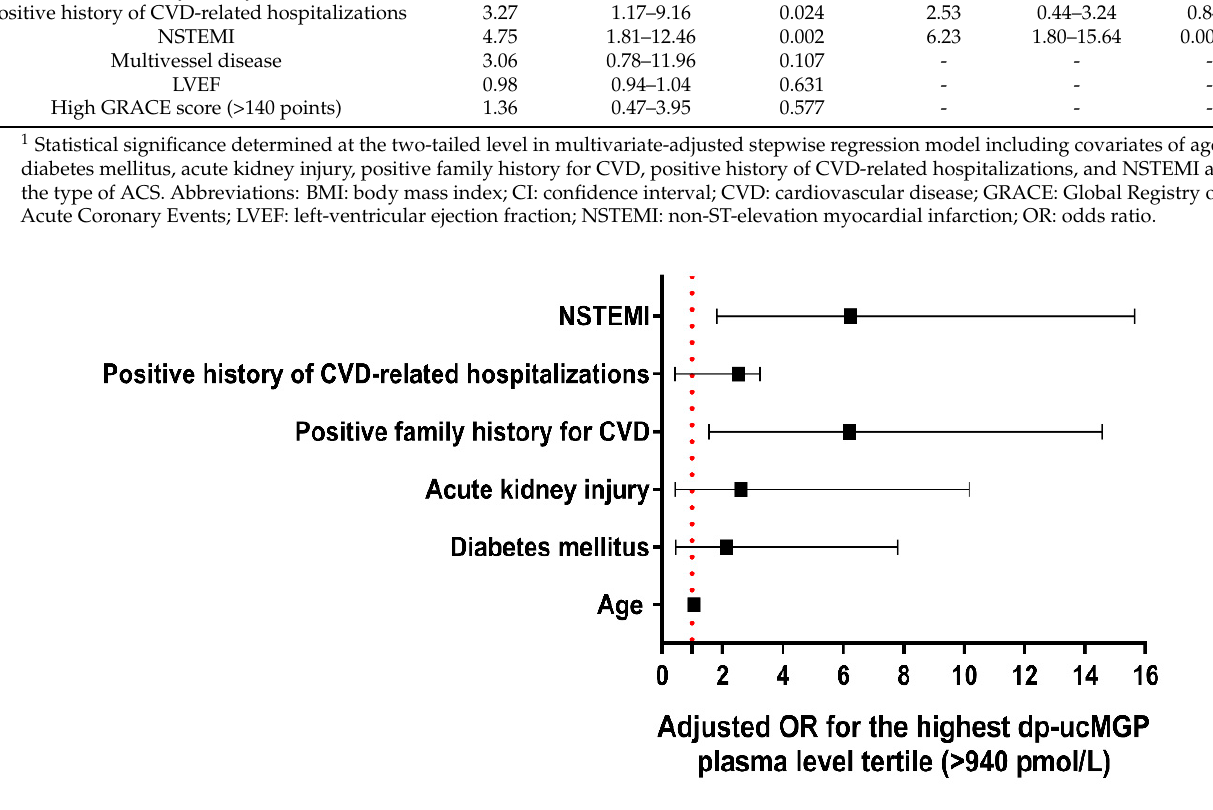
Table 4. Association of dp-ucMGP plasma levels with NSTEMI status adjusted for other con- founding variables in the model of stepwise multivariable logistic regression.